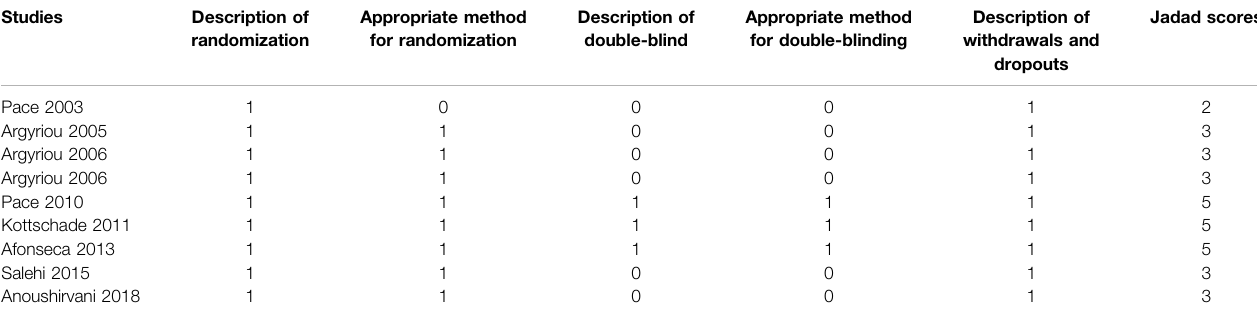
TABLE 2 | Quality assessment of included studies.